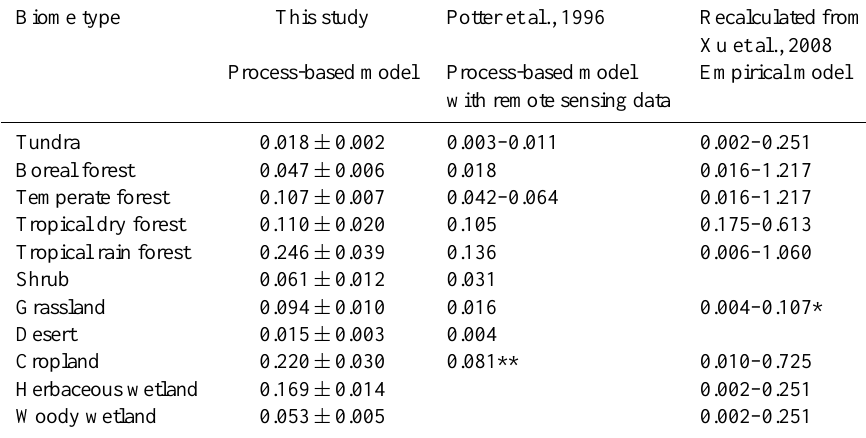
Table 9. Comparison of the DLEM-estimated N 2 O emission rate (gNm − 2 a − 1 ) with other studies at biome level (Positive values represent N 2 O